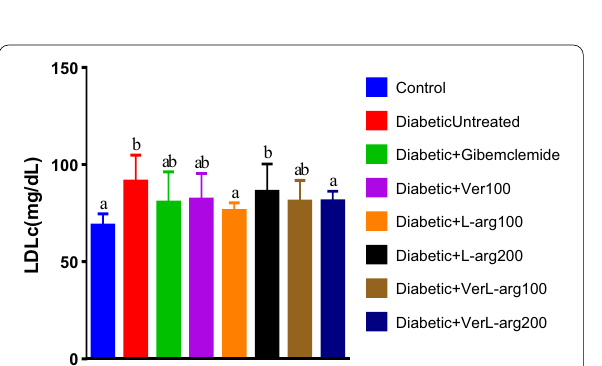
Fig. 9 Low density lipoprotein cholesterol concentration in diabetic mice treated with verbenone, L-arginine and ratios of verbenone L-arginine (1:1 v/m) after 14 days treatment. Values are + expressed as mean SEM, n 5. Values with different superscripts are ± = significantly different at p < 0.05. VerL-arg verbenone L-arginine = + (1:1 v/m)